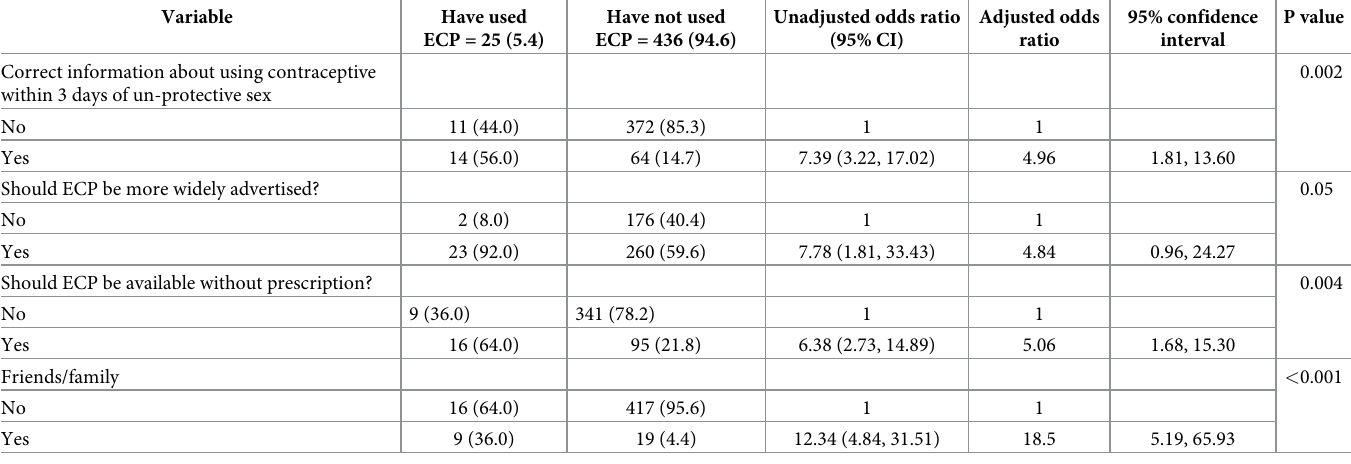
Table 7. Multivariate analysis for the factors for ECP use among men. Variable Have used ECP = 25